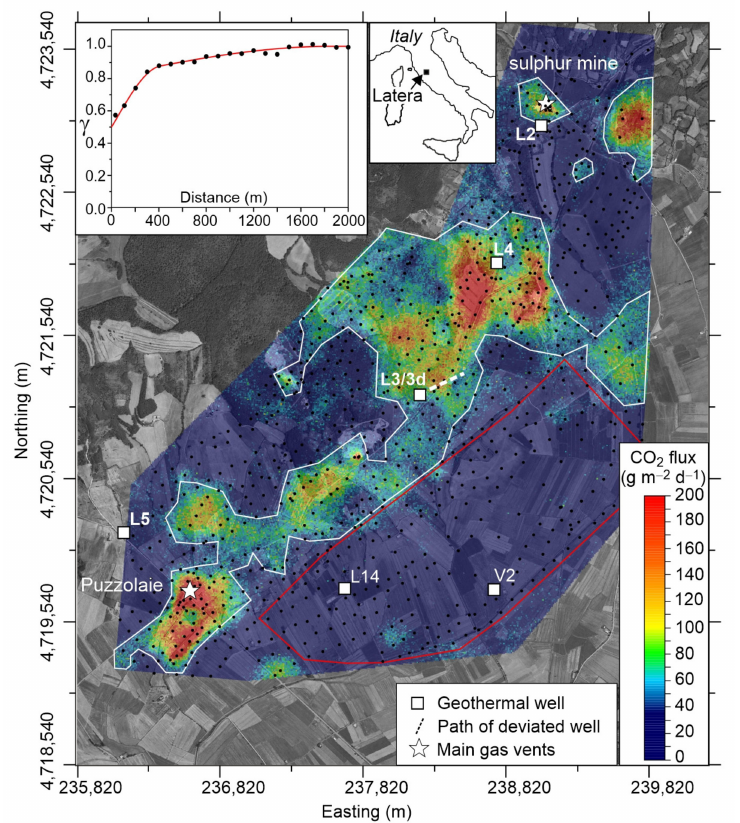
Figure 3. Map of the CO 2 diffuse degassing from Latera obtained through 100 sGs simulations (modified after [12]). In the figure are reported the measurement points (dots); the experimental variogram and the variogram model (red curve) used in the sGs (upper left inset); the contour of the Latera DDS (white line) defined as the area where over 50% of the 100 simulated CO 2 flux values are higher than the biogenic CO 2 flux threshold (50 g m − 2 d − 1 [12]); the contour of the area used to define the biogenic CO 2 background flux (red line); and the location of the main vents and geothermal wells. Coordinates refer to WGS 84/UTM zone 33